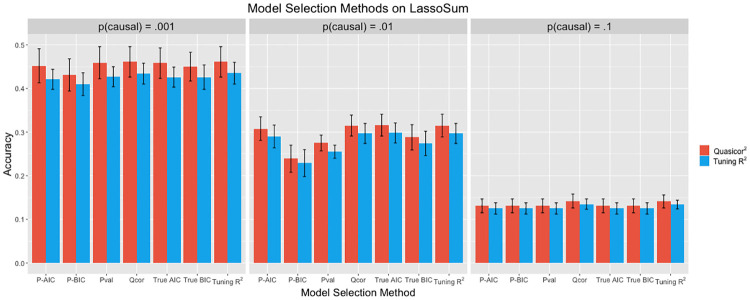
Performance of the seven different model selection methods applied to a set of candidate LassoSum models.Performance is measured by r2 on the testing data (the right bar in each group), and by squared quasi-correlation on the testing data (the left bar in each group). Error bars represent the standard deviation across 20 replications.